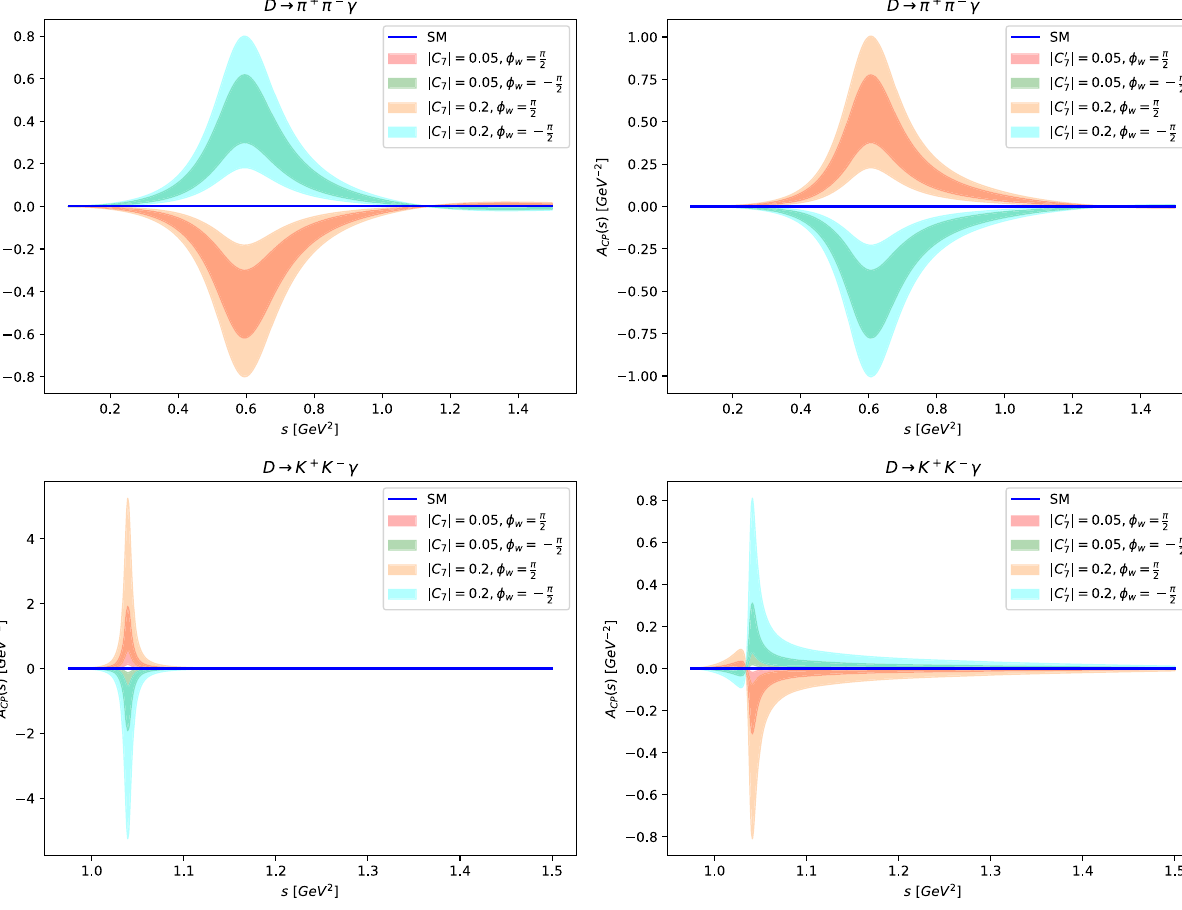
Fig. 11 Predictions for the CP asymmetries in D → π + π − γ and D → K + K − γ as a function of s , within the SM and beyond (using (40)), based on QCDF. For the BSM scenarios, we have set